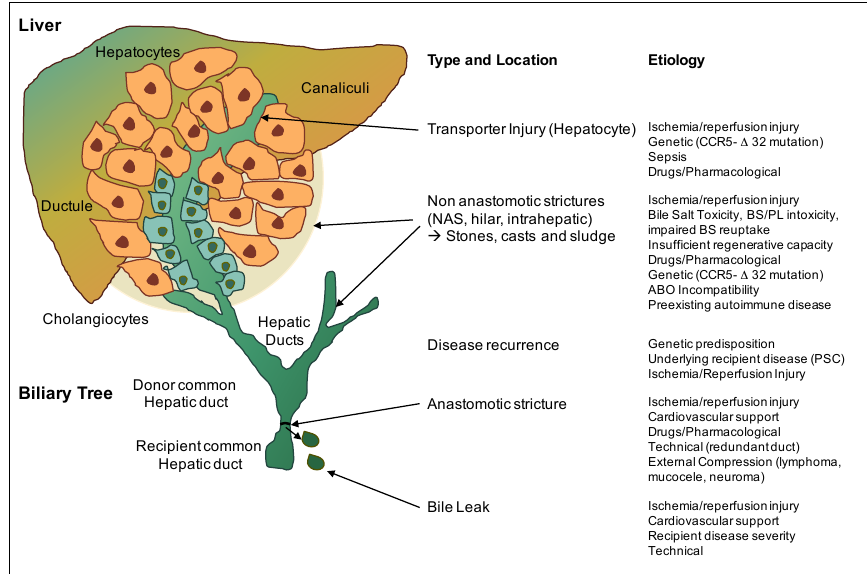
Figure 1: Type and Etiology of injury of the biliary tree after liver transplantation